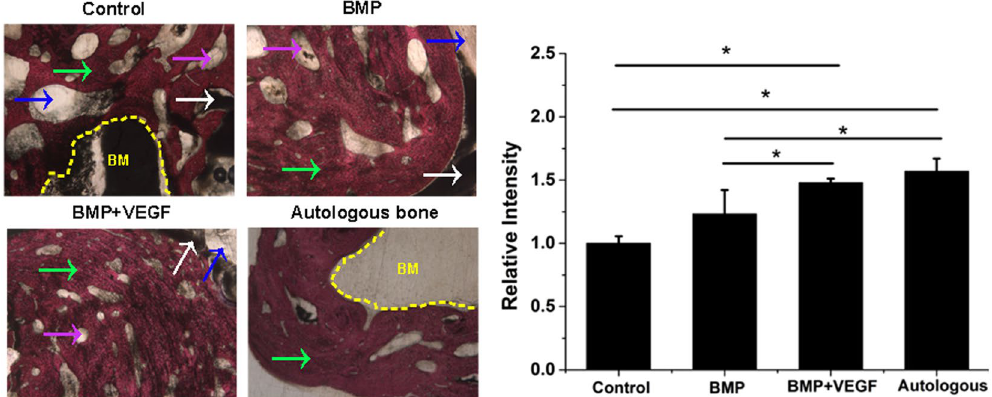
Figure 11. The VG staining of newly formed bone on the interface of implanted scaffolds/autogenous bone and nature bone at defect site of four groups (40 × ) with relevant statistics analysis. Pink arrow refers to PCL pieces, White arrow refers to HA pieces, Blue arrow refers to artificial scaffold,green arrow refers to new bone (NB), yellow area refers to bone marrow cavity